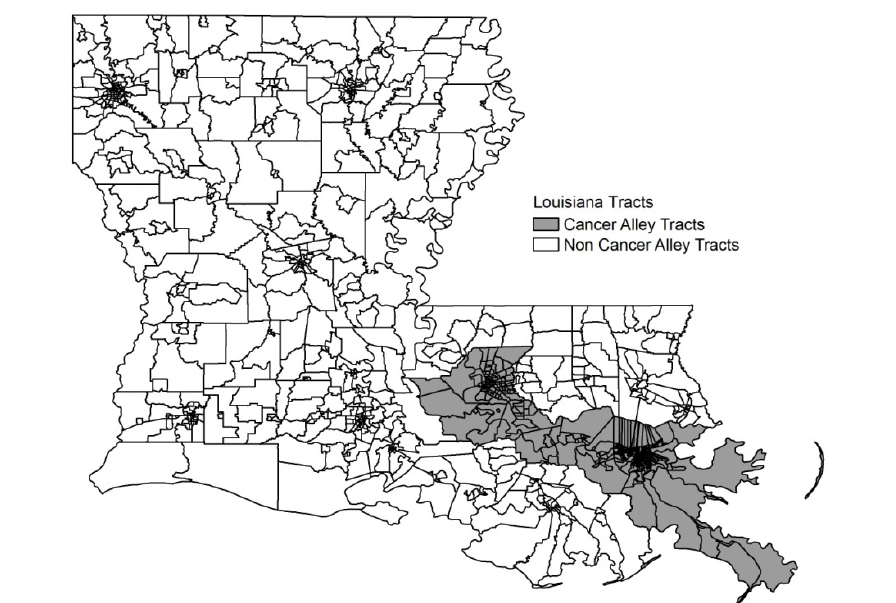
Figure A1. Louisiana and Cancer Alley